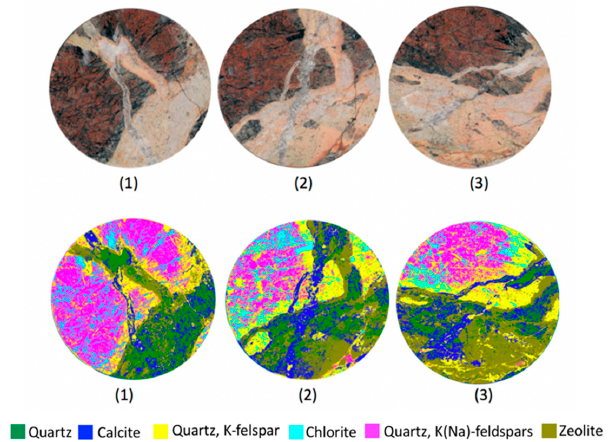
Figure 2. Optical images of three discs of the core sample R-11 ( top ); the same images treated in the ENVI program ( bottom ). Numbers in parentheses indicate disc titles. Table 2. Determination of the part of the area occupied by individual mineral phases on the surface of discs of the R-11 sample using the ENVI program.